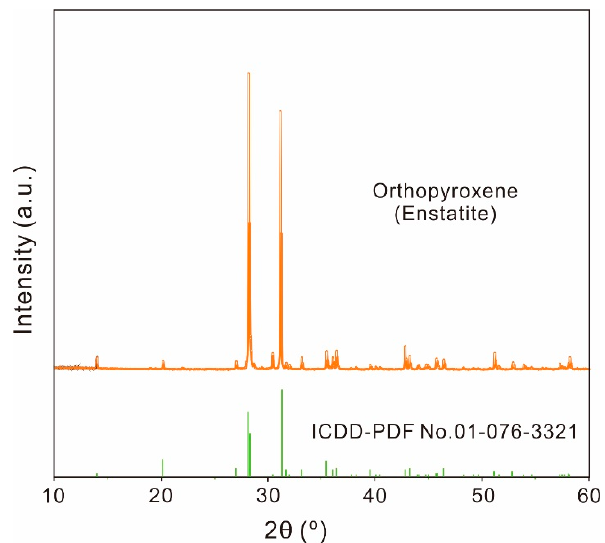
Figure 5. XRD patterns of orthopyroxene obtained via two routes.